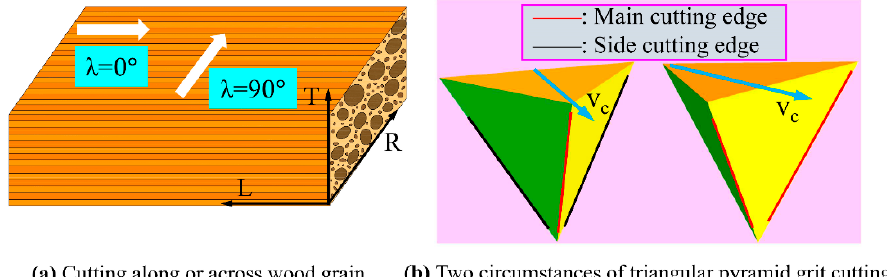
Figure 2. Schematic diagram of a single-grit cutting direction: ( a ) cutting along or across wood grain, and ( b ) two circumstances of triangular pyramid grit cutting.